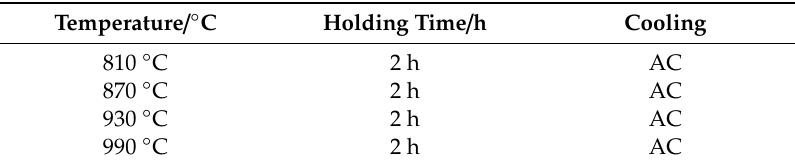
Figure 2. Schema of specimen wire cut electrical discharge machining (WEDM) in mm.